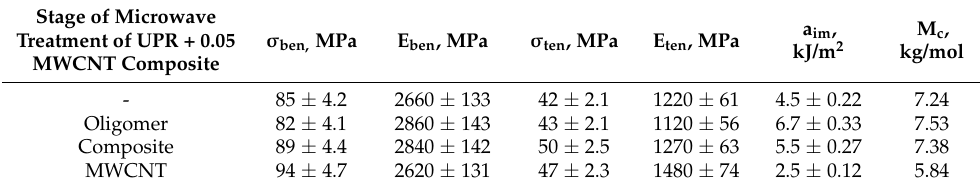
Table 2. Properties of polyester composites. Stage of Microwave Treatment of UPR +